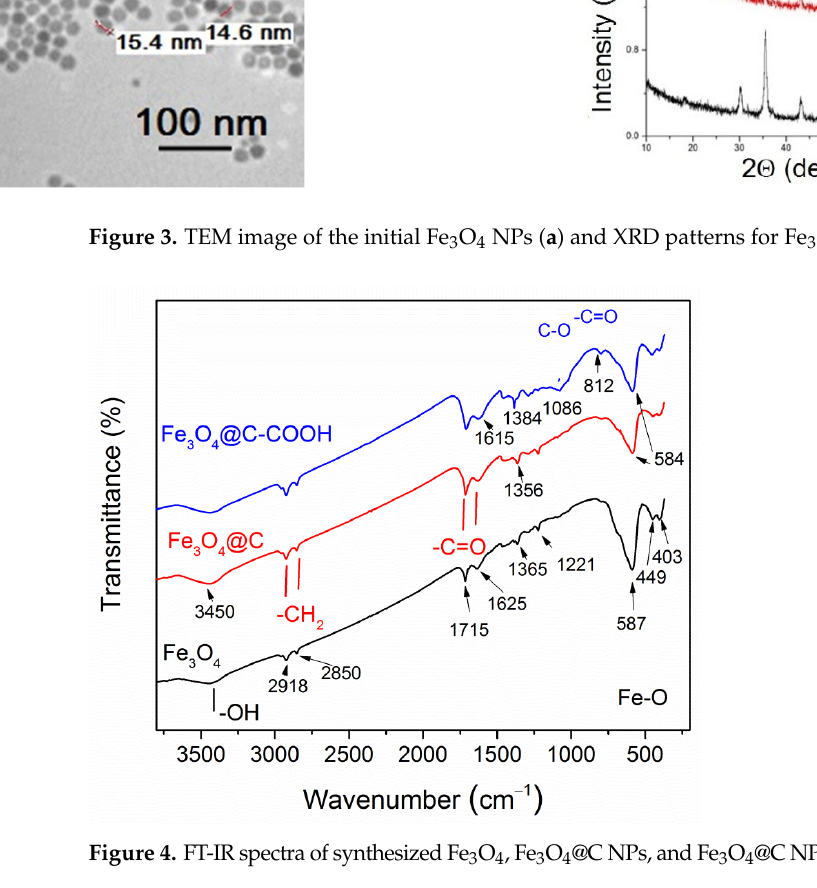
Figure 4. FT-IR spectra of synthesized Fe 3 O 4 , Fe 3 O 4 @C NPs, and Fe 3 O 4 @C NPs after nitric acid treat- ment. The high values of saturation magnetization M s = 79 emu/g in the magnetite NPs and 64 emu/g in the carbon-coated NPs were close to the saturation magnetization of bulk magnetite 84 emu/g (Figure 5). The lower M s value of Fe 3 O 4 @C NPs can be due to a certain